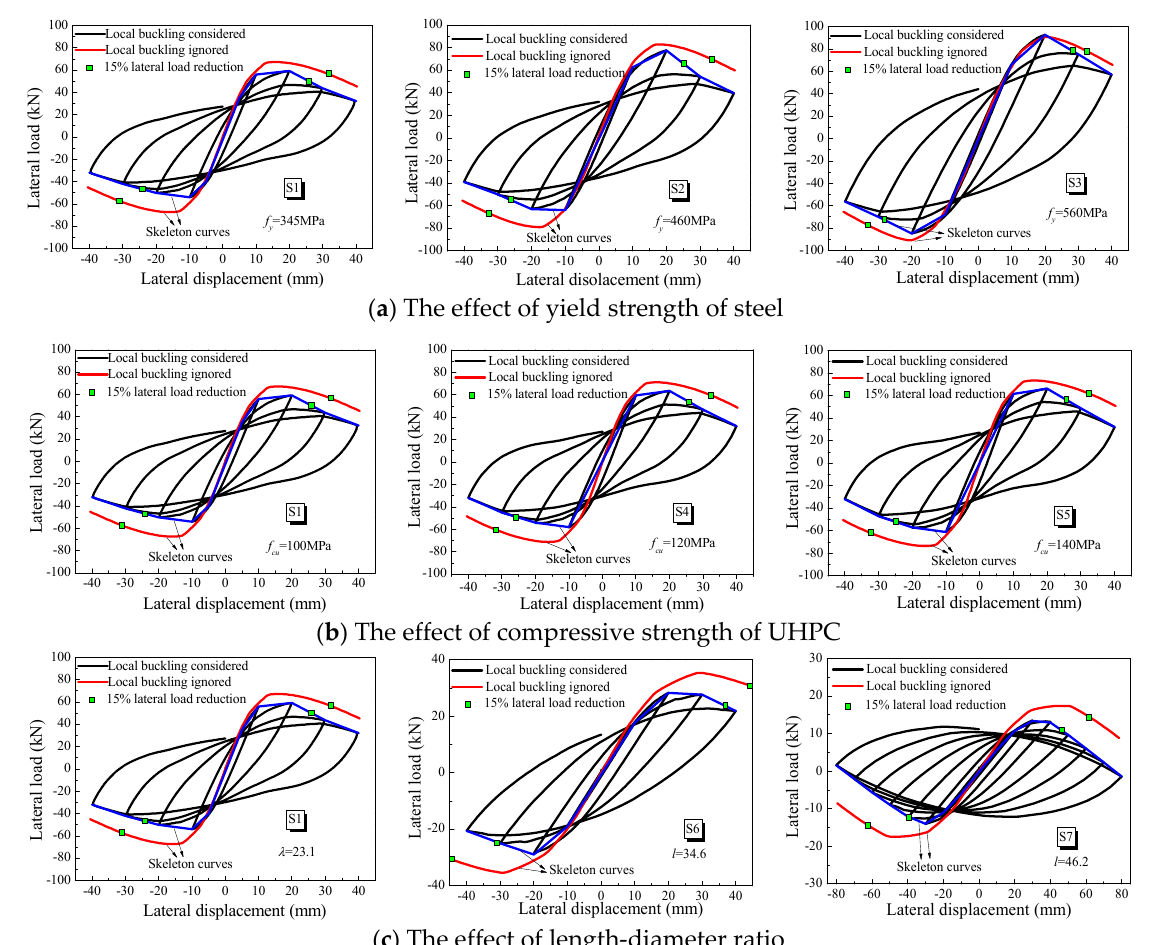
( d ) The effect of the axial compression ratio. Figure 13. The e ff ects of parameters on hysteretic curves. ( b ) Stiffness degradation ( c ) Energy dissipation Figure 14. The e ff ect of the yield strength of steel. ( a ) Bearing capacity ( b ) Stiffness degradation ( c ) Energy dissipation Figure 15. The e ff ect of the compressive strength of UHPC.